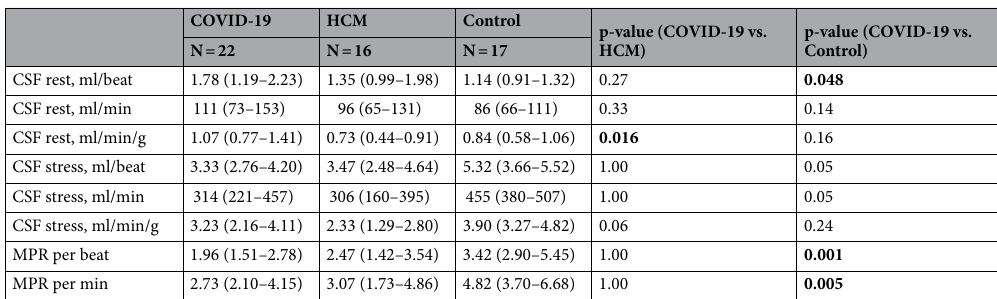
Table 3. Coronary sinus flow (CSF) and global myocardial perfusion reserve (MPR) analysis. Bold values indicates p-value <